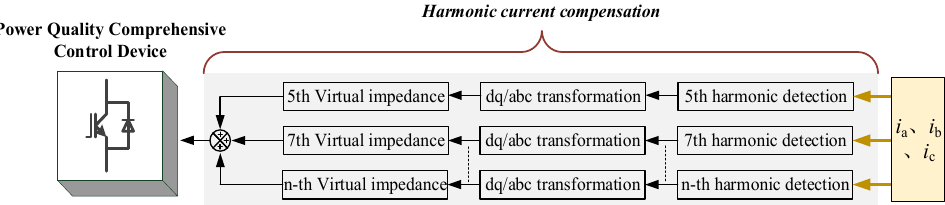
Figure 6. Block diagram of current feed-forward control based on virtual impedance.